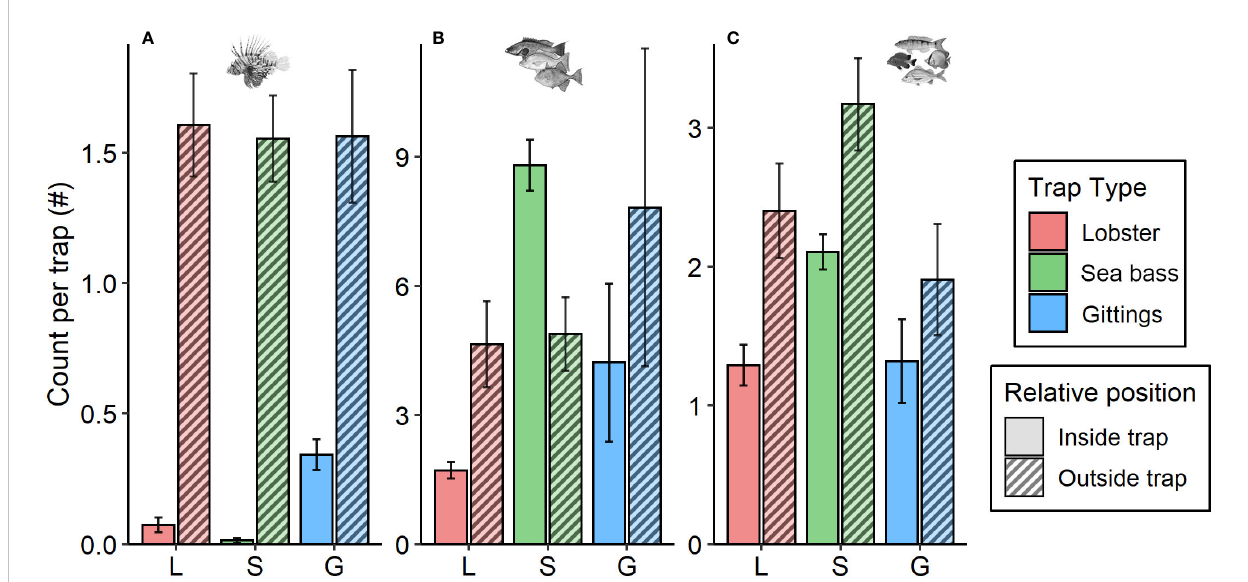
FIGURE 7 In situ recruitment to traps monitored with remote time-lapse videos. Mean (± 95% CI) fi sh count per trap is shown for (A) lion fi sh, (B) native fi shery species, and (C) native non- fi shery species (note scale differences). Fishes were categorized as inside the trap (i.e., inside the lobster or sea bass trap container or within the frame of the Gittings trap) or outside the trap (i.e., visible in the video but not within a lobster or sea bass trap container nor within the footprint of the Gittings trap